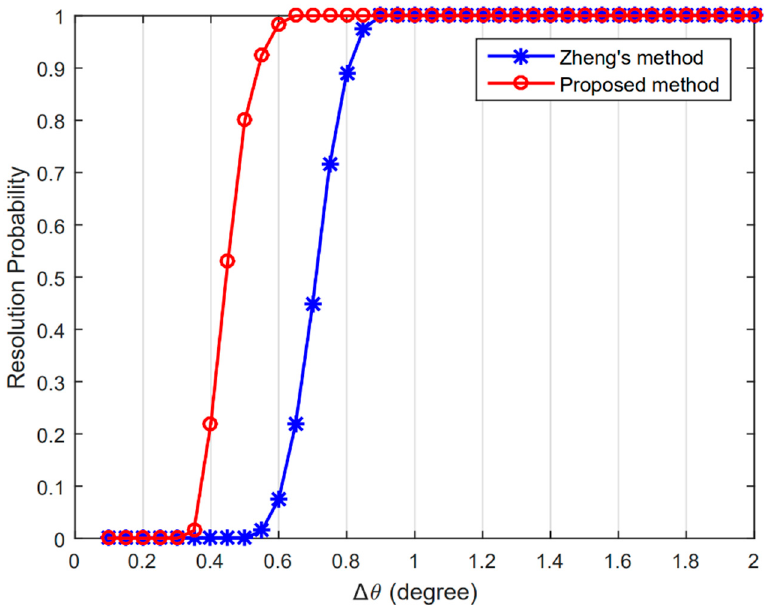
Figure 4. Resolution probability versus ∆ θ